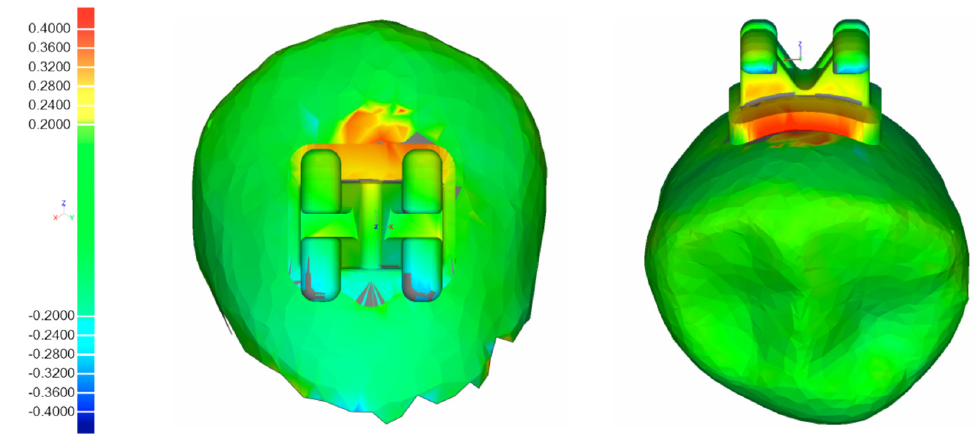
Figure 5. Example of colorimetric best-fit superimposition and bonding inaccuracies. The complete workflow is shown in Figure 1.